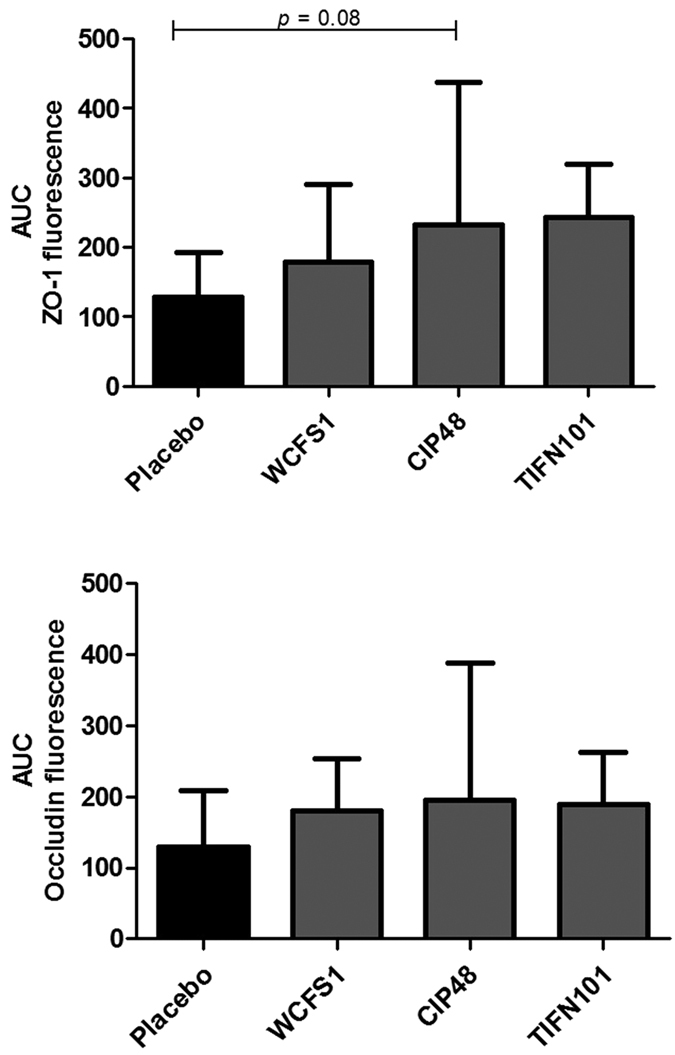
Zonula occludens-1 (ZO-1) and occludin fluorescence intensity in duodenum mucosal tissue after immunofluorescent staining, expressed as area under the curve (AUC), after treatment with placebo or one of the three L. plantarum strains.